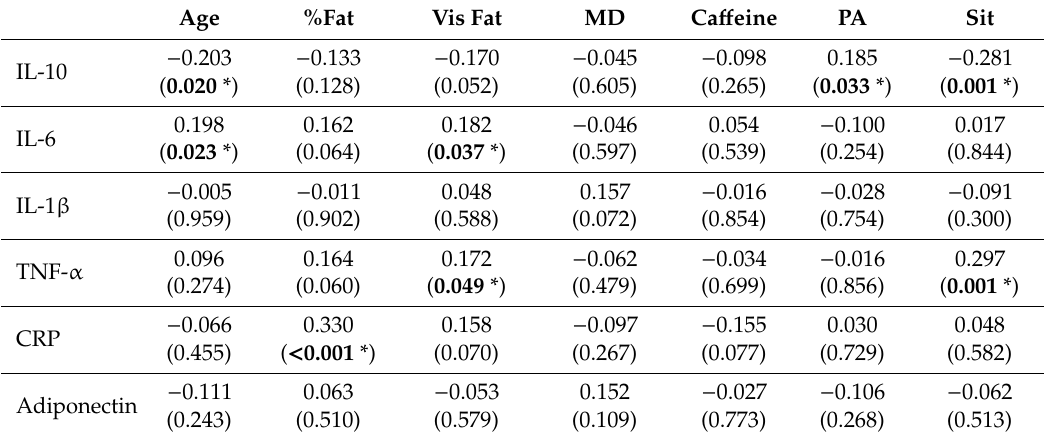
Table 5. Bivariate correlations between dependent and independent variables in females.